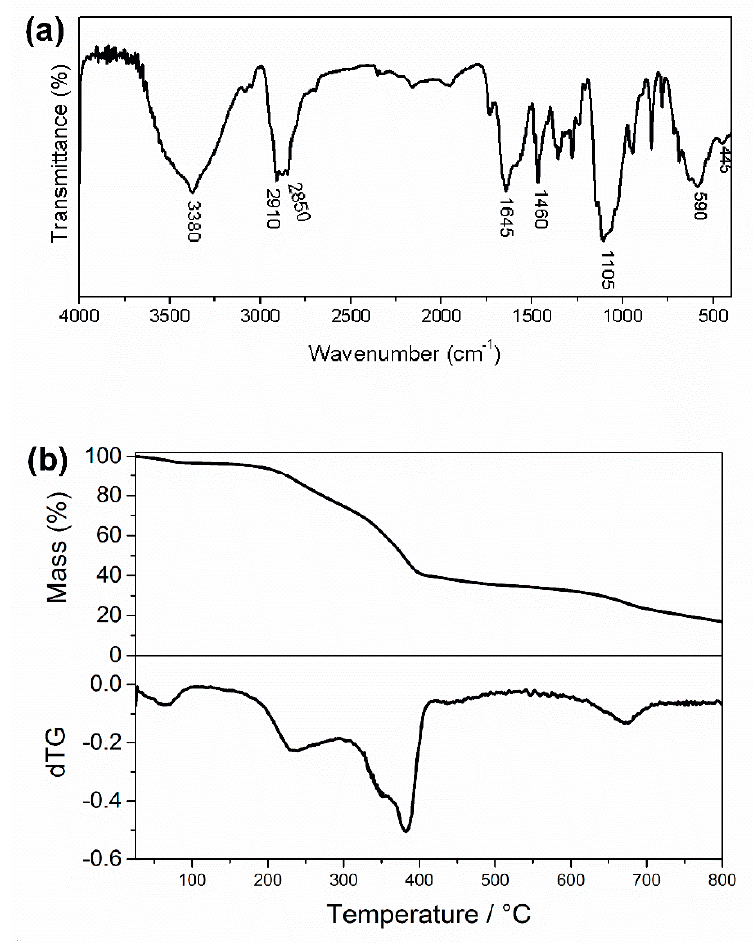
Figure 2. Characterization of the iron oxide nanoparticles-chitosan-cetylpyridinium chloride nanocarrier. Fourier-transform infrared spectra ( a ) and thermogravimetric curve ( b ) obtained for the nanocarrier.